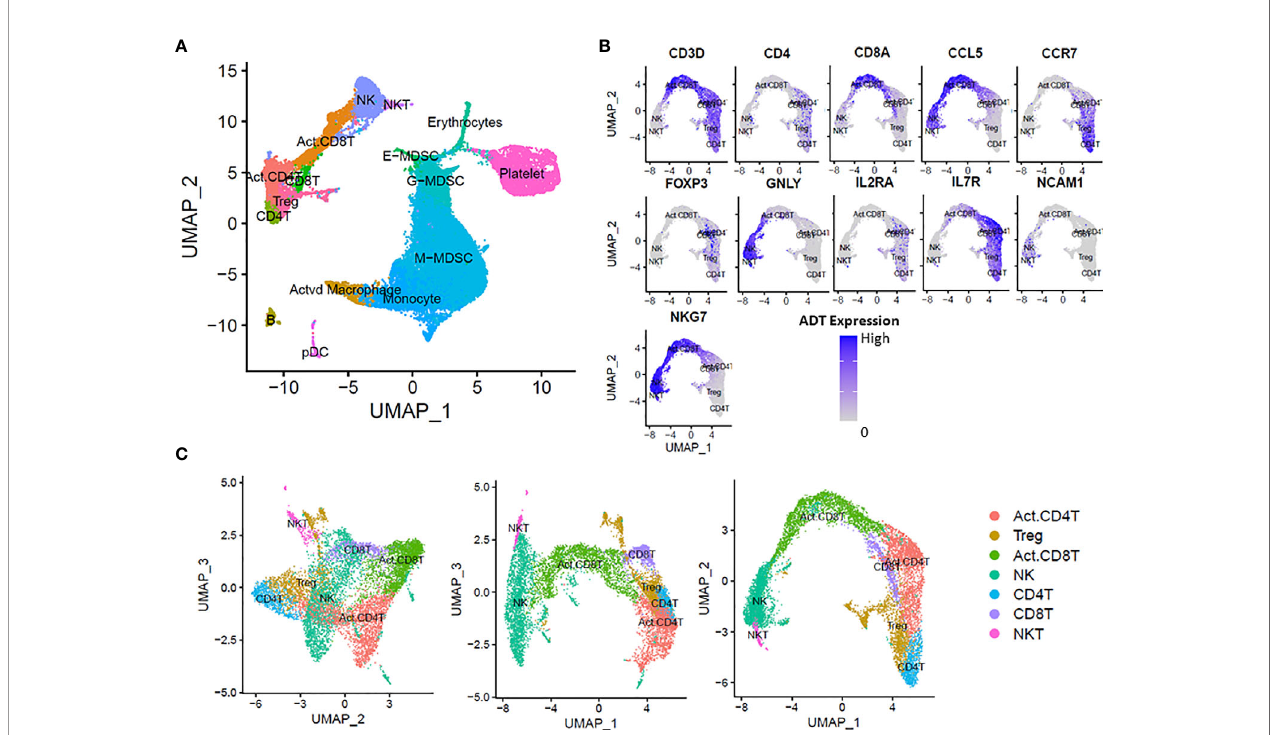
FIGURE 1 | scRNA-seq analysis at 14-21 days post-sepsis versus healthy control. Cells depicted are from all subjects in the study, in each corresponding group (sepsis n=4, healthy n=5). Using Seurat ’ s method of integrating data across conditions/batches, the integration allows for joint clustering and to identify shared (or possibly unshared) cell clusters. Cells are visualized on uniform manifold approximation and projection (UMAP) plots colored by cell types. (A) UMAP representation of cell clusters identi fi ed in healthy patients versus late sepsis. (B) Annotation of T-lymphocyte subsets was performed manually using expression of CD3D, CD4, CD8A, CCL5, CCR7, FOXP3, GNLY, IL2RA, IL7R, NCAM1 and NKG7 . (C) UMAP representation of T-cell subset clusters from manual annotation identi fi ed in healthy patients versus late sepsis in three dimensions. (E-MDSC, early myeloid derived suppressor cell; G-MDSC, granulocytic myeloid derived suppressor cell; M-MDSC, monocytic myeloid derived suppressor cell; pDC, plasmacytoid dendritic